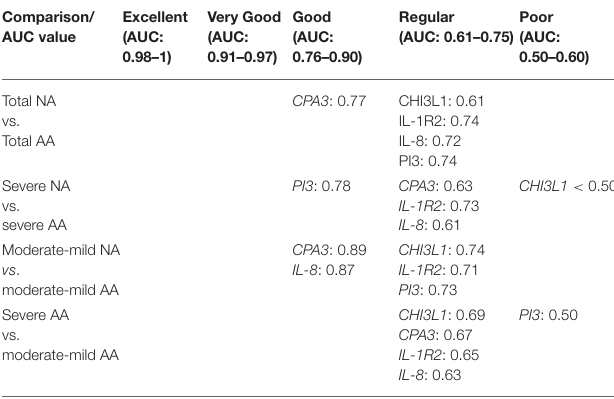
TABLE 2 | Classification of biomarkers by receiver operating characteristic (ROC) curves analysis at the genetic